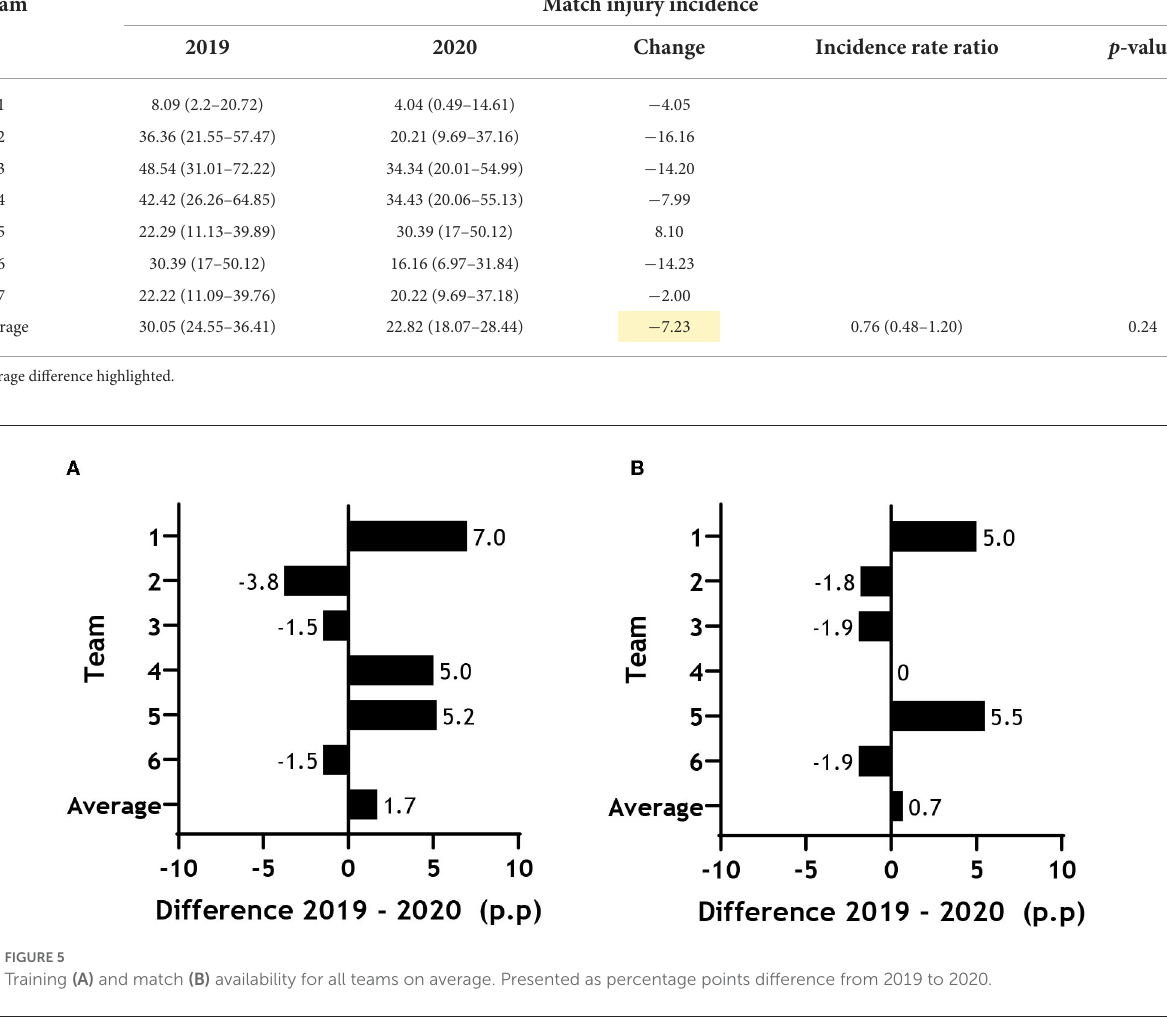
preseason preparation in the Norwegian premier league is likely to have mitigated some of the injury risk